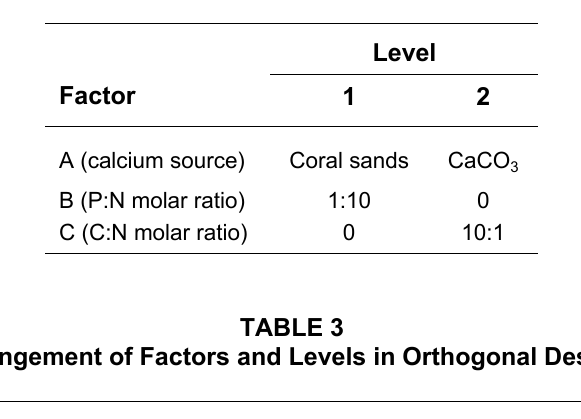
Experiment Factors and Levels Used in this Study